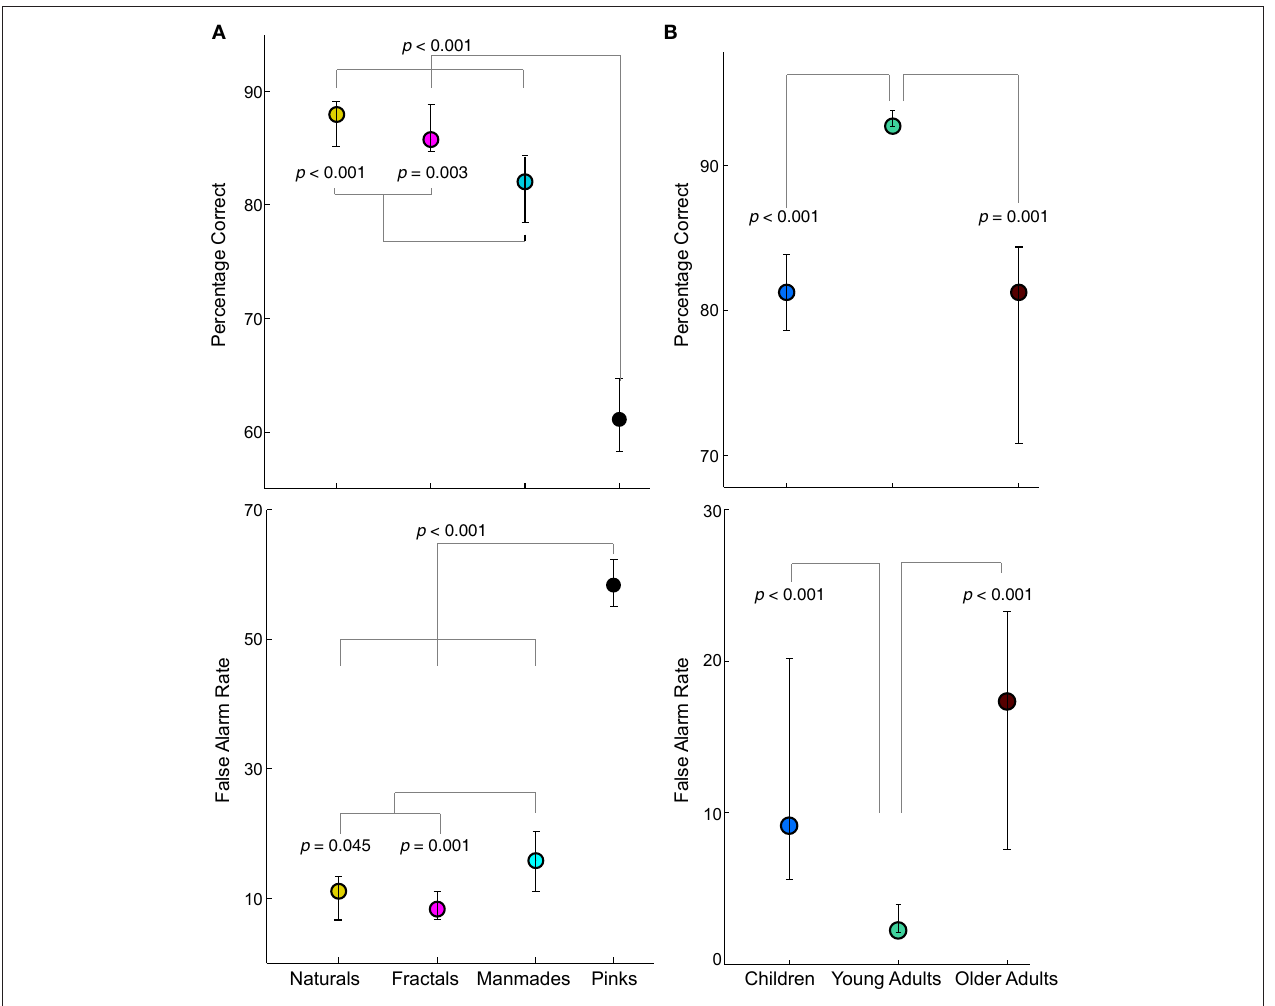
Figure 2 | Performance in the delayed pattern-matching task. (A) Category- specific performance. In the upper panel, for each image and age group the percentage correct was computed separately, and then the mean over age was taken. Circles show category medians, and error bars denote 95% confidence intervals (CIs). The branching lines connect significantly different ( p < 0.05) categories and p -values are shown next to the branches, down to p = 0.001. The very low pinks performance is striking. Lower panel shows category-specific false alarm (FA) rate. All conventions are identical to the upper panel.